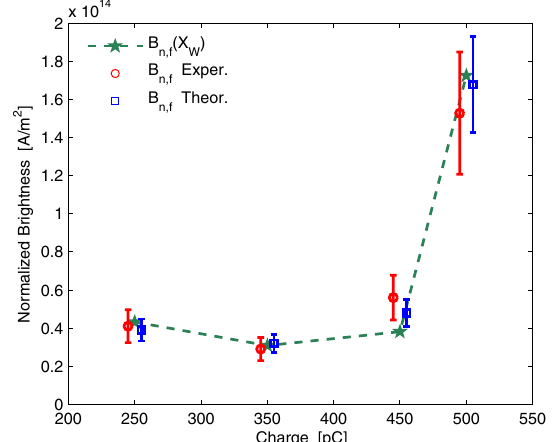
FIG. 3. Measured (circles) and predicted (squares) normalized brightness at the end of the FERMI linac as a function of the beam charge. The compression factors are 7, 6, 6, and 12 for beam charge values of 250, 350, 450, and 500 pC, respectively. The compression and charge markers are shifted in the abscissa for better reading. The dashed line, which is used to guide the eye, represents Eq. (6) when only GTW is considered.